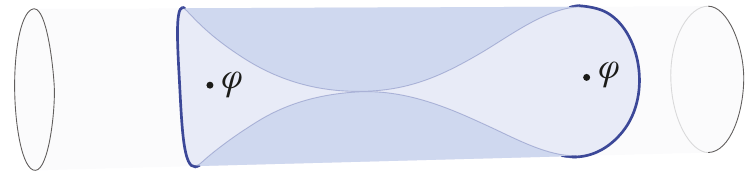
Figure 1. The OPE on S 1 (cid:2) R d (cid:0) 1 is valid if the two operators lie inside a sphere. The largest (cid:12) possible sphere has diameter (cid:12) , wrapping entirely around the S 1 such that it is tangent to itself. Here, we illustrate such a sphere (blue) in d =